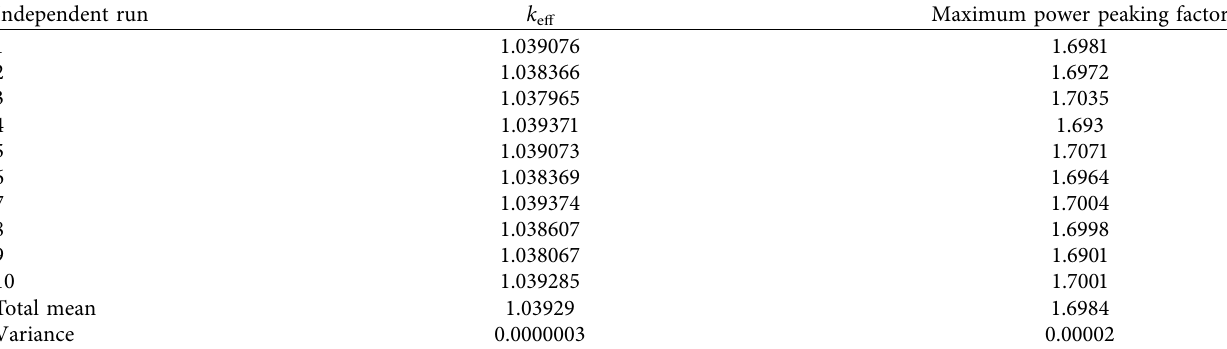
Table 5: Stability study of MGA in the first 10 independent simulations.